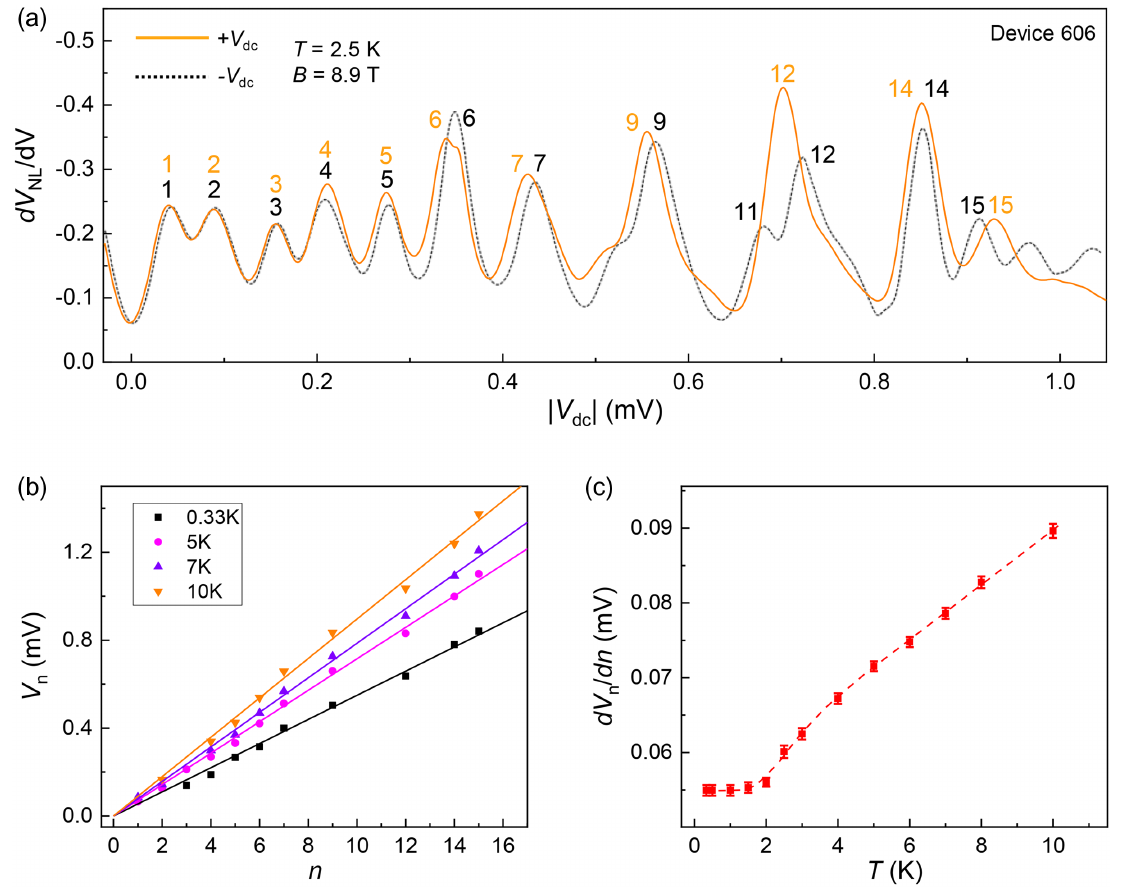
=dV and analysis for positive dc bias in device 606. (a) compares dV FIG. 11. dV NL V (black dotted line) at T ¼ 2 . 5 K with the resonance peaks labeled for both traces. The two data overlap very well. (b) V dc number n at selected temperatures and linear fits to the data. (c) Temperature dependence of the slope dV in (b). The low- T slope of 0.055 mV yields v